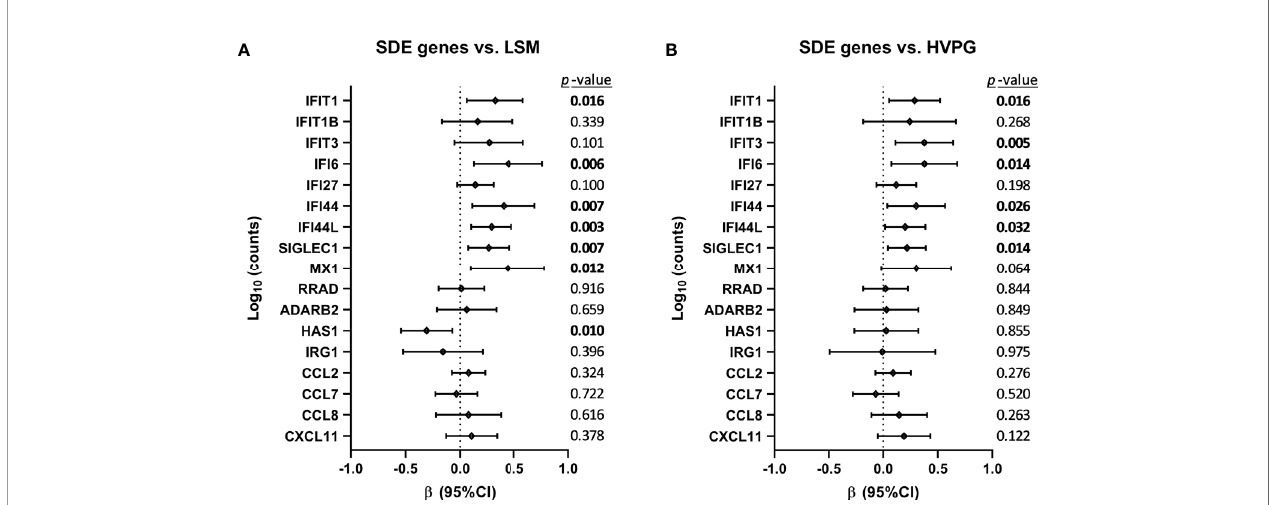
FIGURE 4 | Association between changes in signi fi cant differentially expressed (SDE) genes and liver disease severity scores (A) [liver stiffness measurement (LSM) and (B) hepatic venous pressure gradient (HVPG)] after successful all-oral direct-acting antiviral treatment in HIV/HCV-coinfected patients with advanced cirrhosis. Data were calculated by GLMM models. Values are expressed as regression coef fi cient ( b ) and 95% of con fi dence interval (95%CI). The statistically signi fi cant differences are shown in